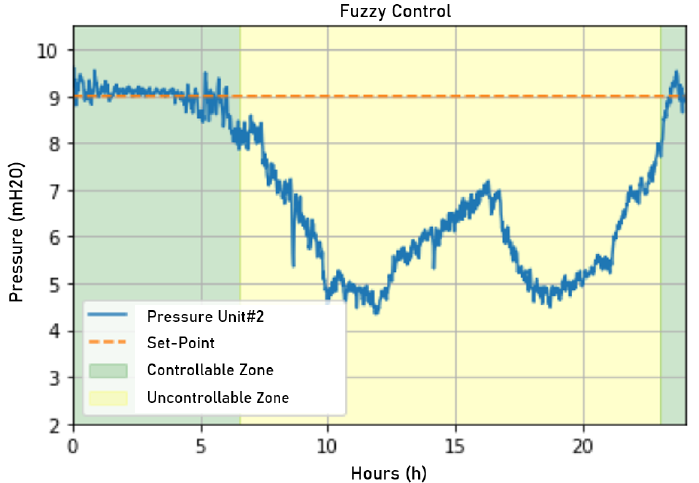
Figure 28. Pressure measured on the first day when applying fuzzy control. Source: